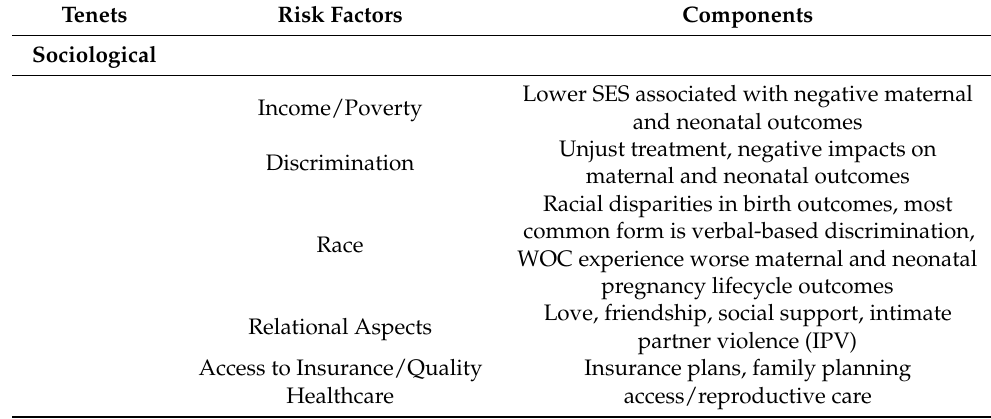
Table 1. Cont. Tenets Risk Factors Components Sociological Lower SES associated with negative maternal Income/Poverty and neonatal outcomes Unjust treatment, negative impacts on Discrimination maternal and neonatal outcomes Racial disparities in birth outcomes, most common form is verbal-based discrimination, Race WOC experience worse maternal and neonatal pregnancy lifecycle outcomes Love, friendship, social support, intimate Relational Aspects partner violence (IPV) Access to Insurance/Quality Insurance plans, family planning Healthcare access/reproductive